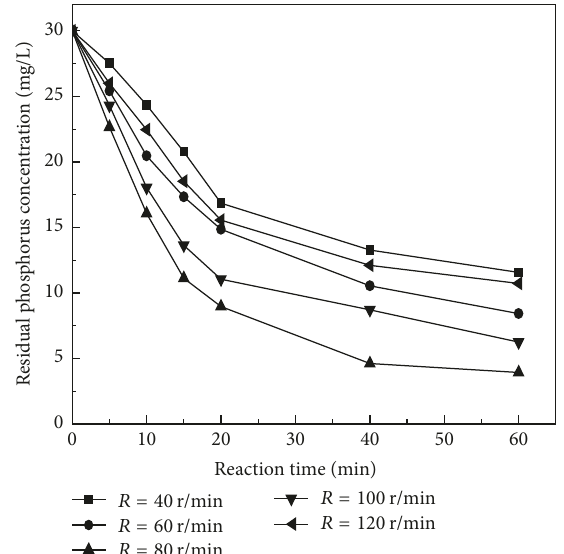
Figure 7: The effect of stirring speed on phosphorus recovery system (initial concentration of phosphorus, 30 mg/L; initial pH, 7.0; P-CSHs-PEG2000 dosage, 1.0 g/L).